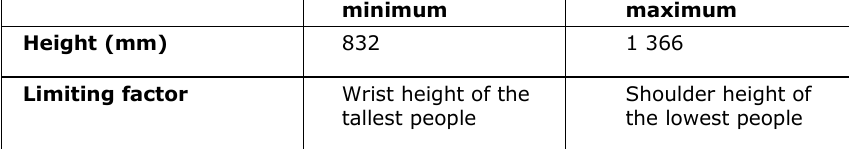
Table 1. Ergonomic considerations regarding the supermarkets design.